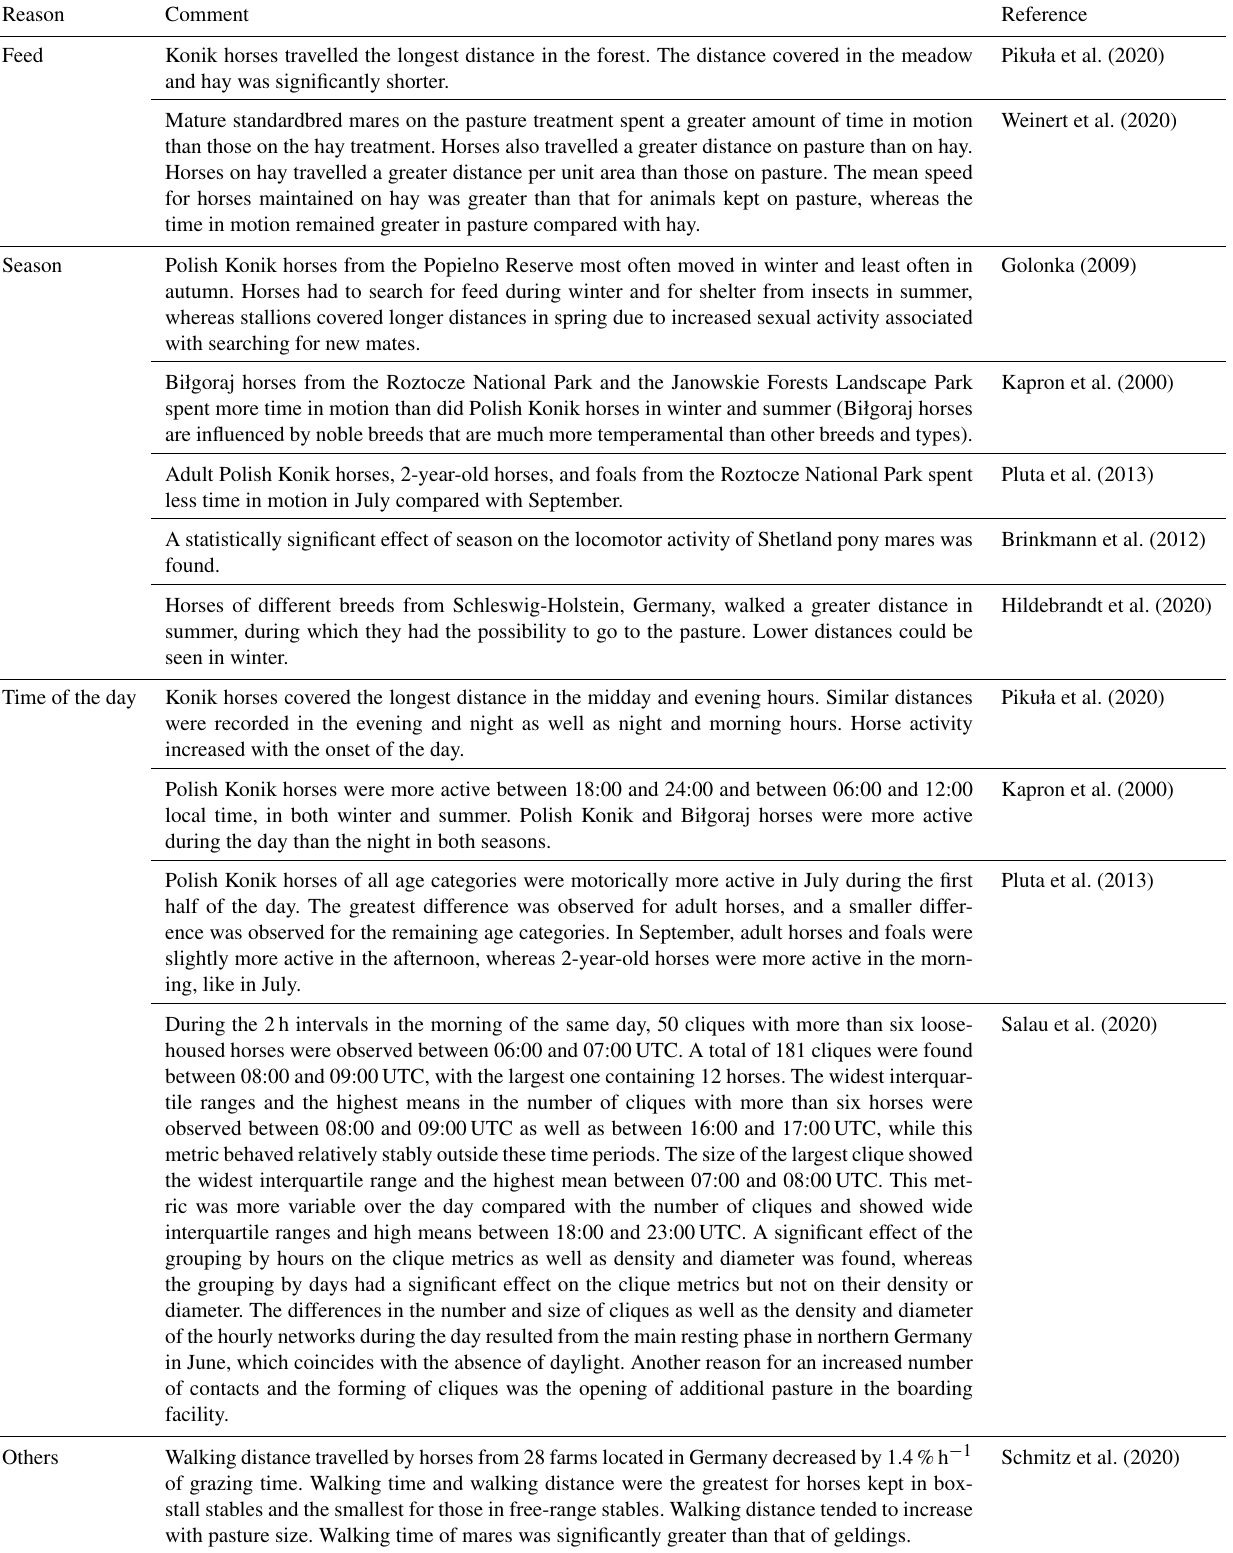
Table 4. Reasons for mobility in different horse